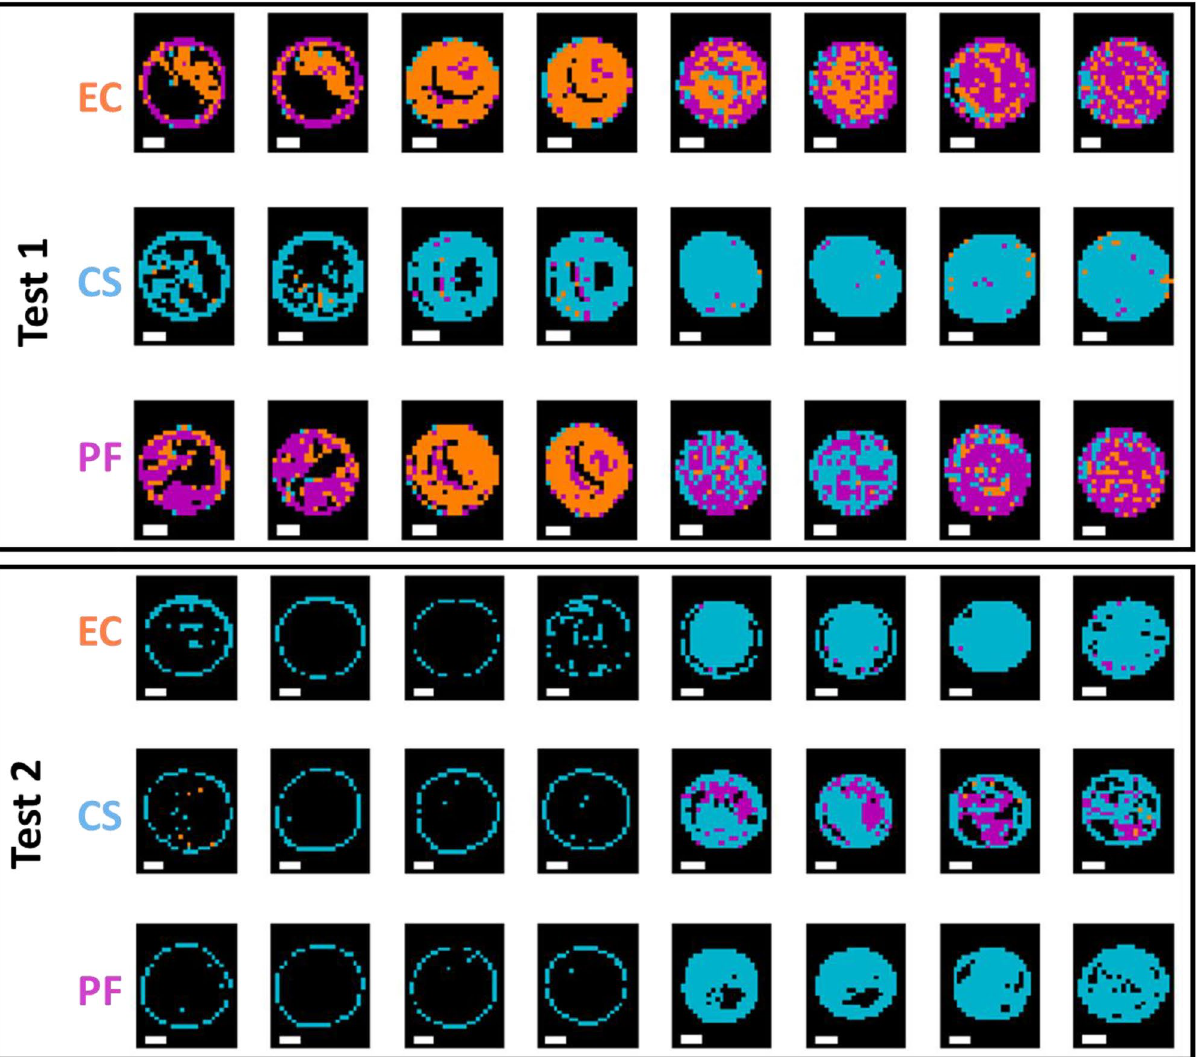
Figure 8. Classification maps for samples in the test set (reps 6, 9, 12, and 16) obtained from the best pixel- level FTIR models for GN EC/CS/PF classification (pixels classified as EC/CS/PF are shown in orange, blue or magenta respectively). Each replicate has two drops. EC: Escherichia coli , CS: Cronobacter sakazakii ; PF: Pseudomonas fluorescens. White scalebar indicates 1 mm (width) × 0.2 mm